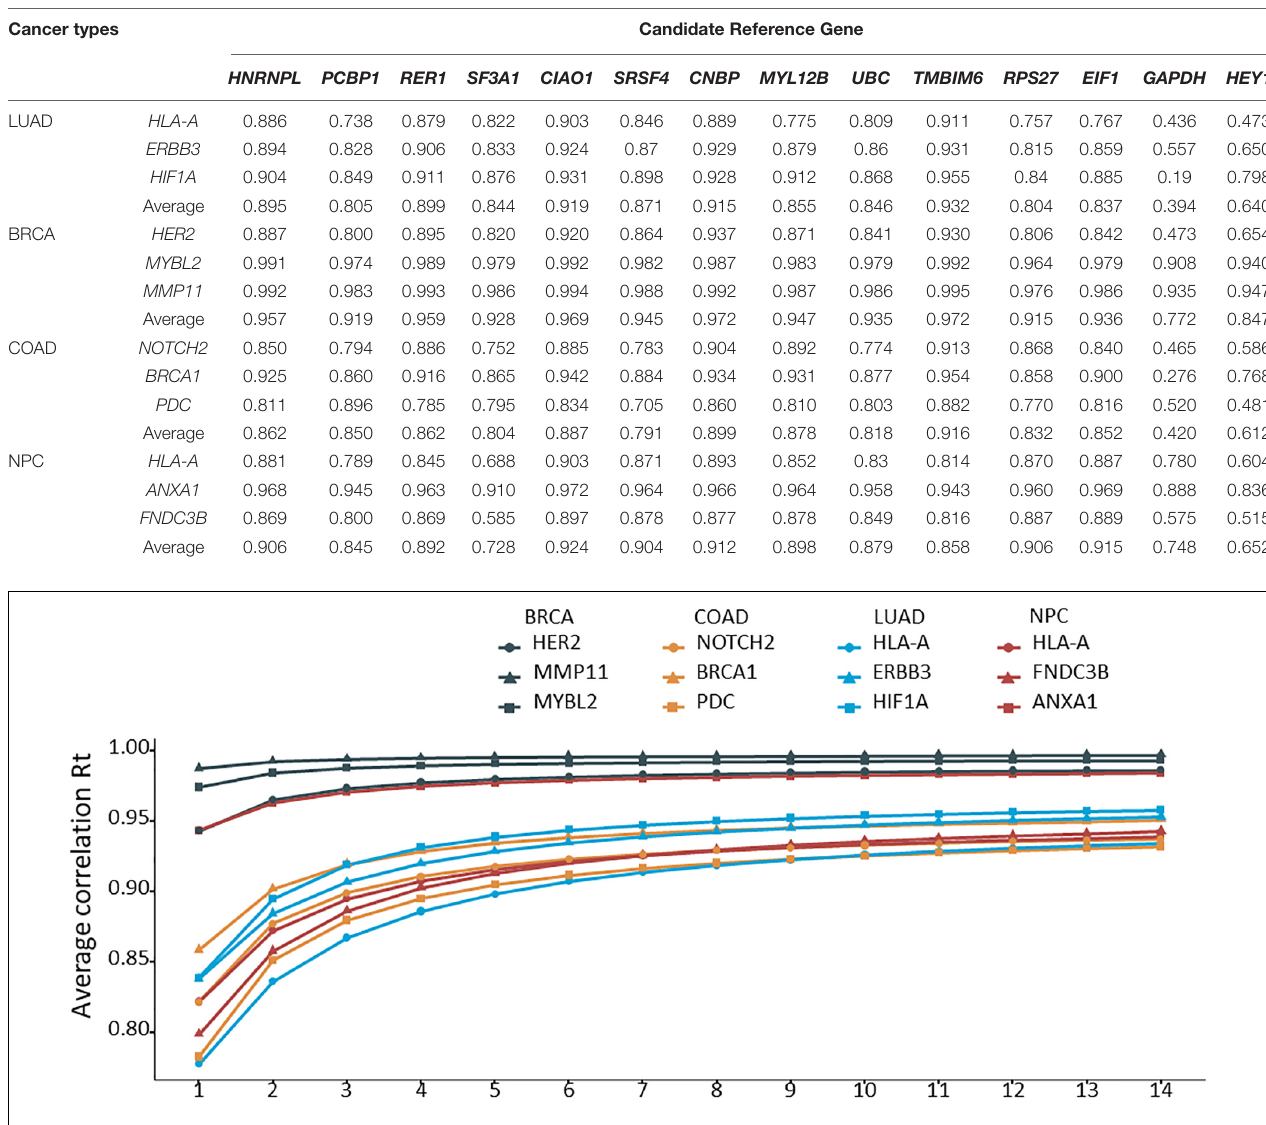
TABLE 2 | Target gene Rt and average Rt of each single reference gene in four types of cancers. Cancer types Candidate Reference Gene